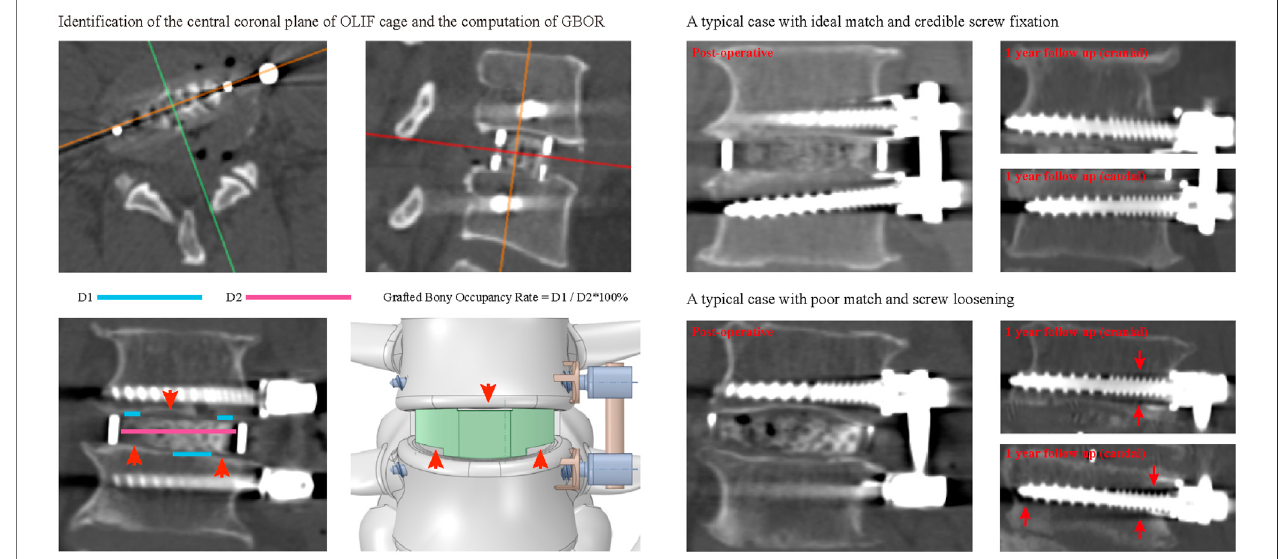
FIGURE1| Theschematic ofthede fi nition and surgicalsimulationsofGBOR, and typical cases fordifferentcontact suf fi ciency and resulting screw fi xation status.